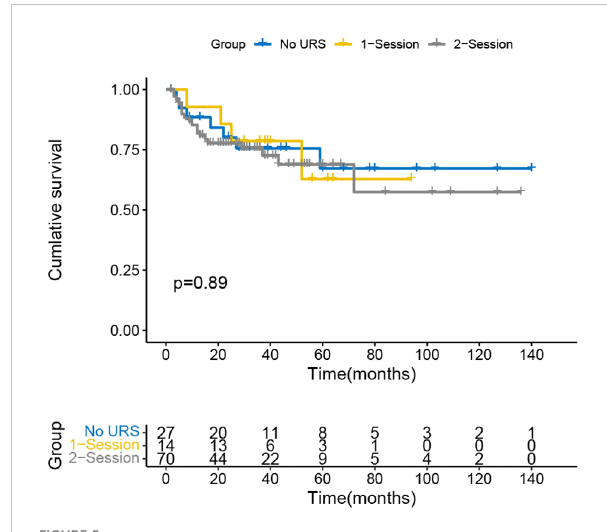
FIGURE 5 Survival analysis of intravesical recurrence in patients with ureteral